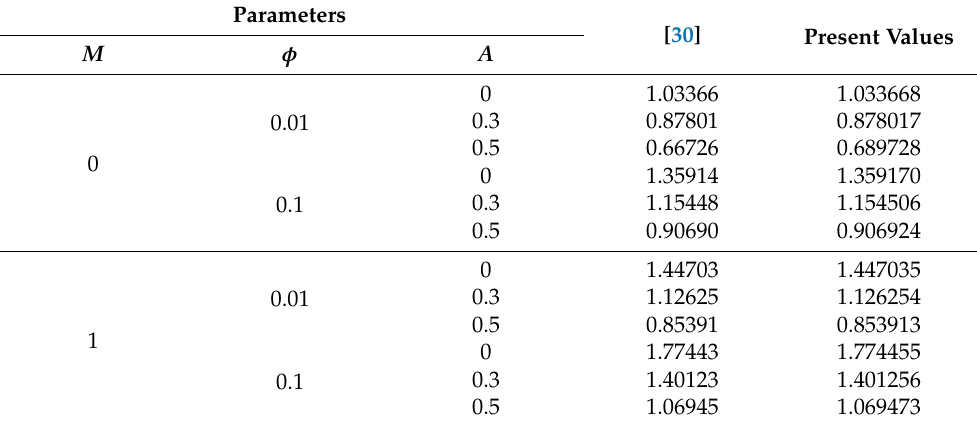
Table 3. Comparison of − C f Re 1/2 x for a water-based ferrofluid (Fe 3 O 4 ) with the variation of M , φ and A . Parameters